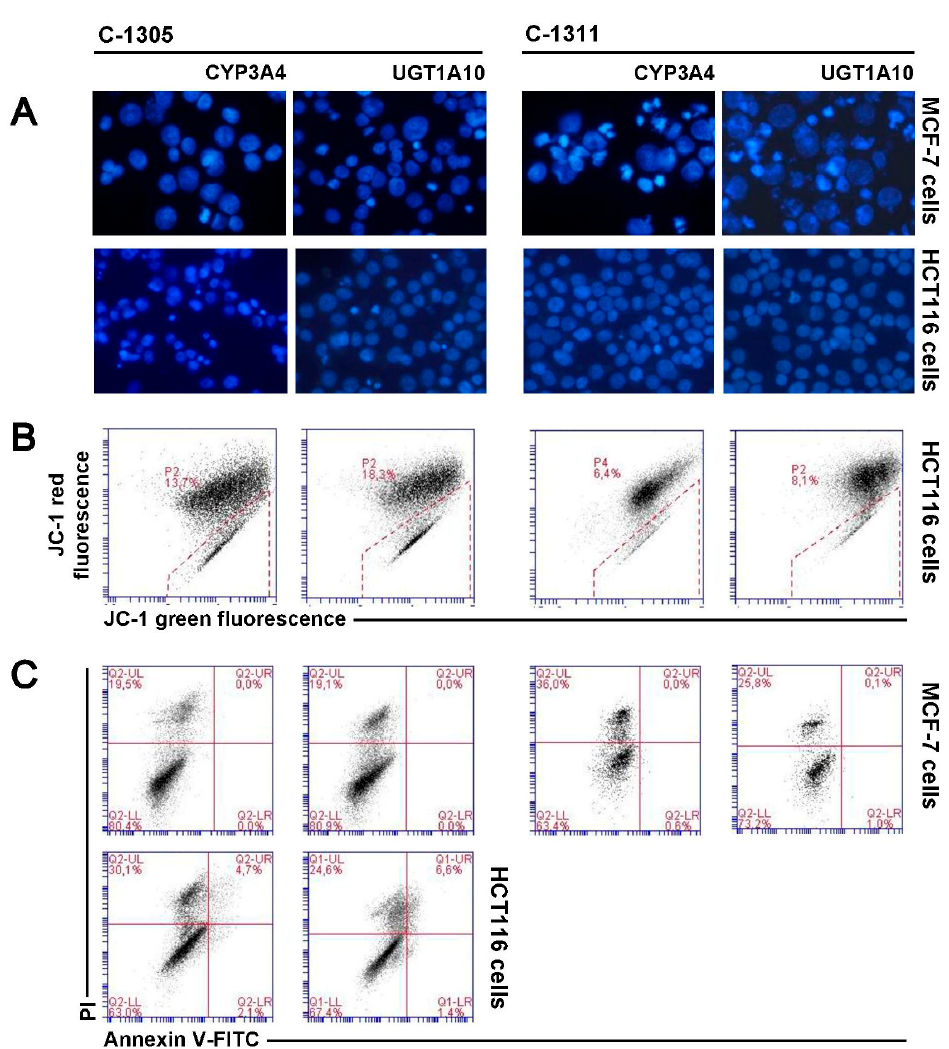
Figure 8. Cellular response of MCF-7-CYP3A4, MCF-7-UGT1A10, HCT116-CYP3A4 and HCT116-UGT1A10 cells to 120 h of C-1305 and C-1311 treatment. ( A ) Representative analysis of changes in nuclear morphology of two types of MCF-7 and HCT116 cells exposed to C-1305 and C-1311 (IC 80 for MCF-7, IC 90 for HCT116). Cells were stained with DAPI (1 mg / mL) and visualized under fluorescent microscope (400 × magnification); ( B ) Cytometric analysis of changes in mitochondrial transmembrane potential ( ∆Ψ m) in two types of HCT116 cells treated with both compounds and labeled with JC-1 dye. Cytograms are representative of three independent experiments. Marked gates are populations of cells with decreased mitochondrial transmembrane potential ( ∆Ψ m) (green fluorescence); ( C ) Phosphatidylserine externalization and membrane disruption in two types of MCF-7 and HCT116 cells after 120 h of treatment with C-1305 and C-1311. Representative bivariate flow cytometry histograms of annexin V-FITC signal versus PI signal. Bottom left quadrant represents live cells (annexin V negative, PI negative); bottom right quadrant represents early apoptotic cells (annexin V positive, PI negative); top right quadrant represents late apoptotic cells (annexin V positive, PI positive); top left quadrant represents primary necrotic cells (annexin V negative, PI positive). Annexin V / PI test could not be performed for HCT116 cells because of too high autofluorescence of 10 µ M C-1311.